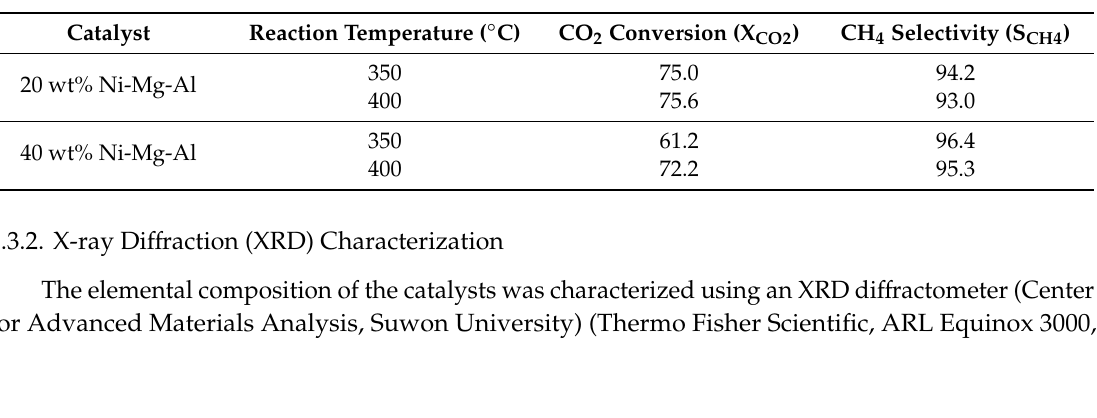
Table 4. CO 2 conversion and selectivity of CH 4 with di ff erent Ni